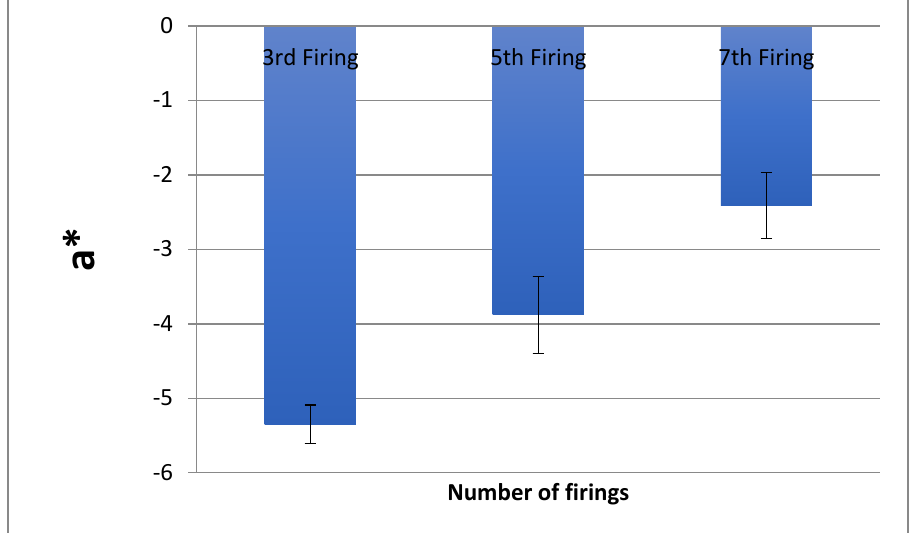
Figure 2. L* comparison of samples after the third, fifth, and seventh firings.